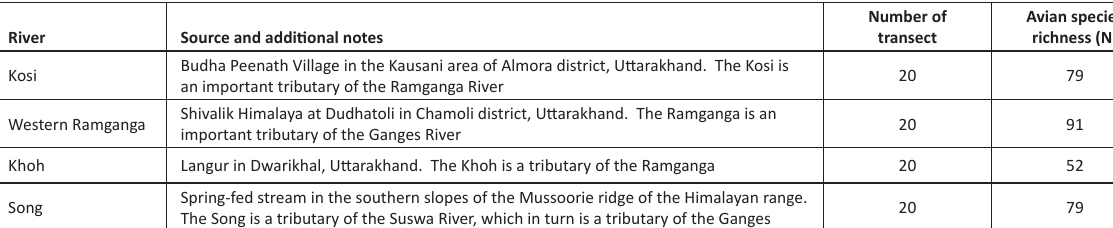
Table 1. Key descriptors of the four surveyed rivers in Uttarakhand. River